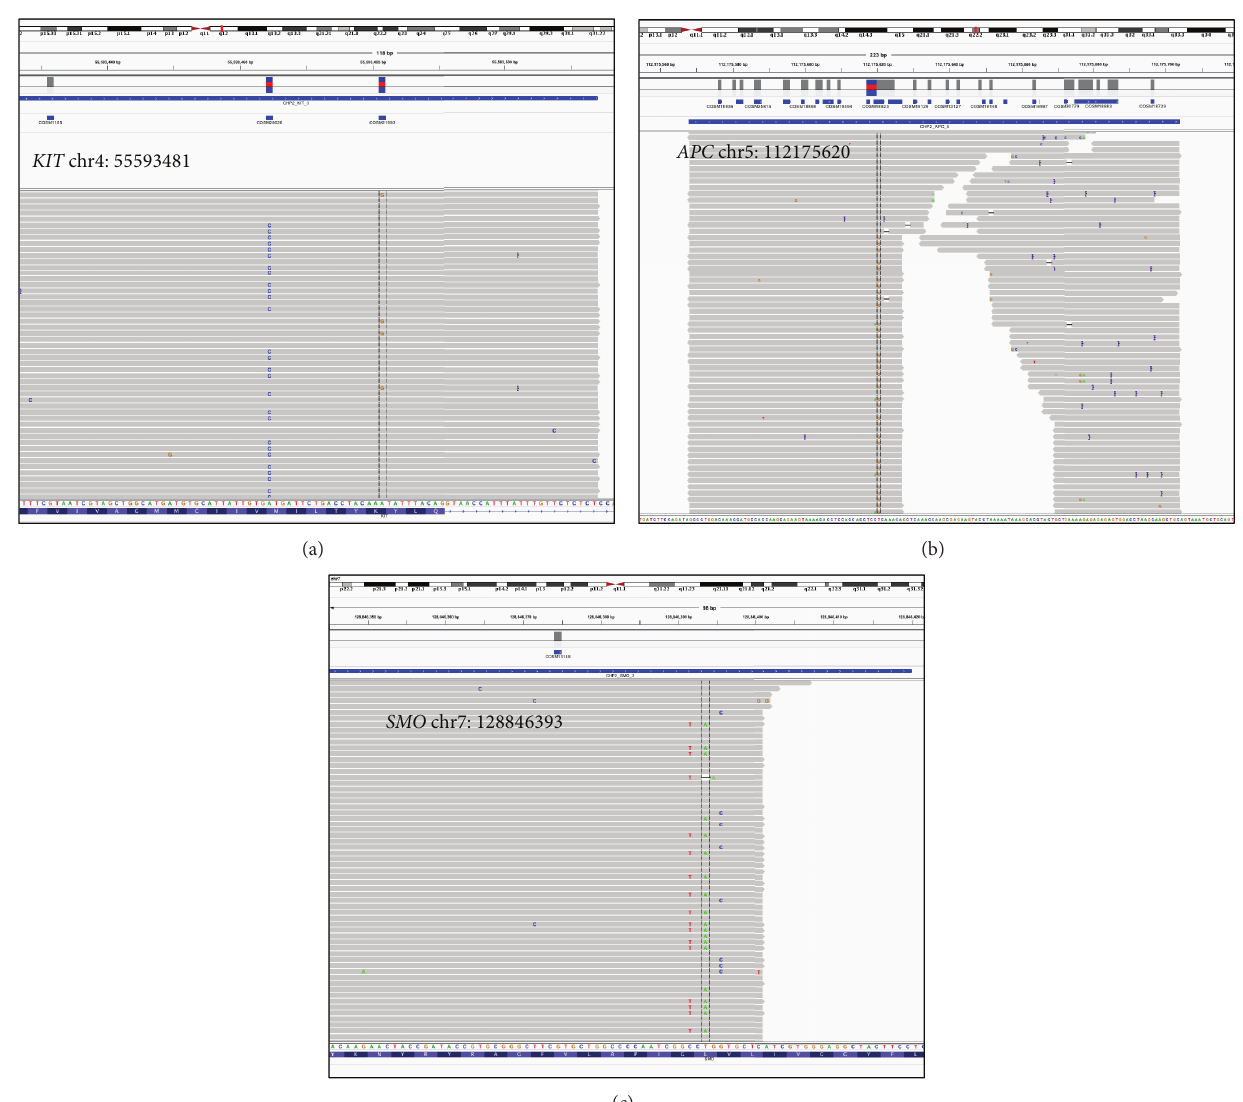
Figure 3: Representative snapshots of Integrative Genomics Viewer (IGV, Broad Institute, Boston, MA) showing the aligned reads for the rare variants detected in samples exposed to 1Gy of ionizing radiation. (a) At position chr4:55593481 in the KIT protooncogene of H1 cells. (b) At position chr5:112175620 in the tumor suppressor gene APC of H9 cells. (c) At position chr7:128846393 in the SMO oncogene of H9 cells. Each horizontal grey bar represents an individual read with the variant highlighted with vertical columns (A > G in panel (a), and T > G in panel (b), and T > A in panel